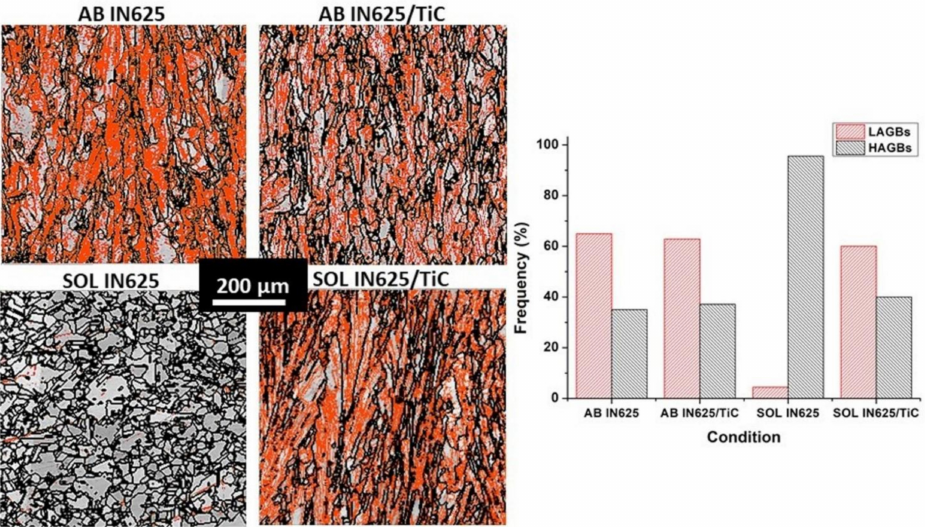
Figure 3. EBSD images of the grain misorientation distributions of the IN625 and IN625/TiC conditions with the chart of the frequency of LAGBs and HAGBs. The HAGBs are marked in black, while the LAGBs are pointed out in